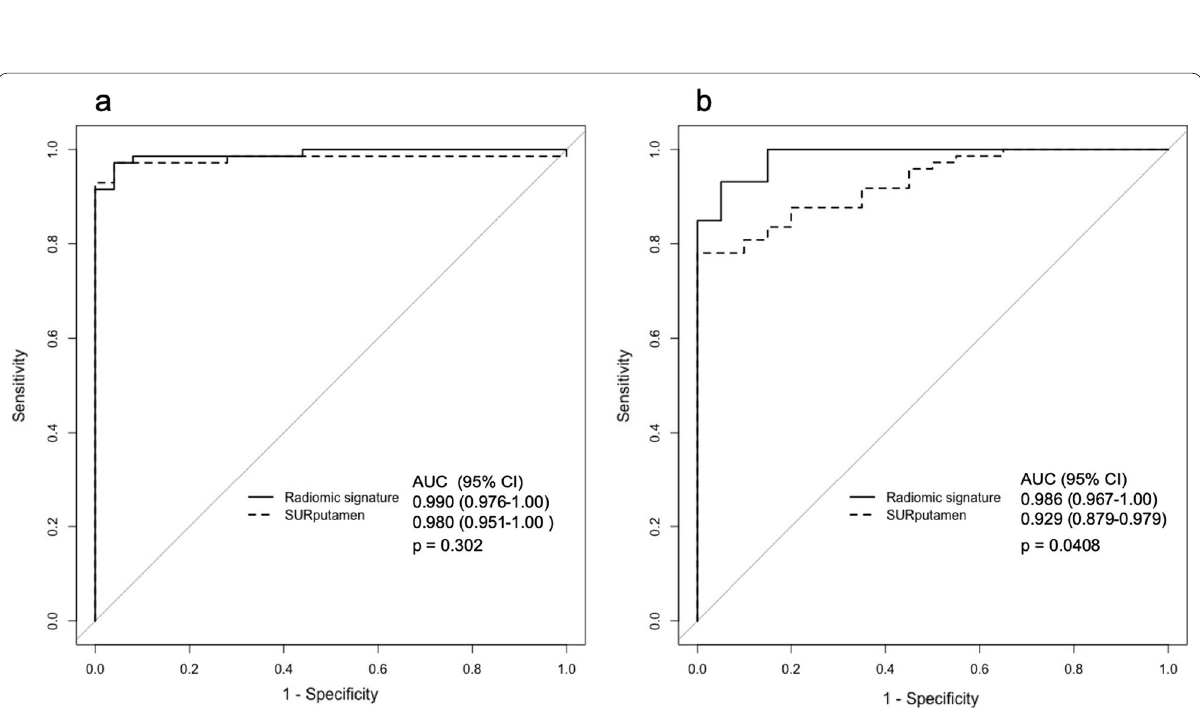
Fig. 6 Comparison of receiver operating curves between radiomics signature and striatum uptake ratio of the putamen. a The AUCs for the test dataset 1of the radiomics signature and SUR putamen were 0.990 (95% CI, 0.976–1.00) and 0.980 (95% CI, 0.951–1.00), respectively ( P AUCs for the test dataset 2 of the radiomics signature and SUR putamen were 0.986 (95% CI, 0.967–1.00) and 0.929 (95% CI, 0.879–0.979), respectively ( P 0.041). AUC area under the curve, CI confidence interval, SUR striatum uptake =